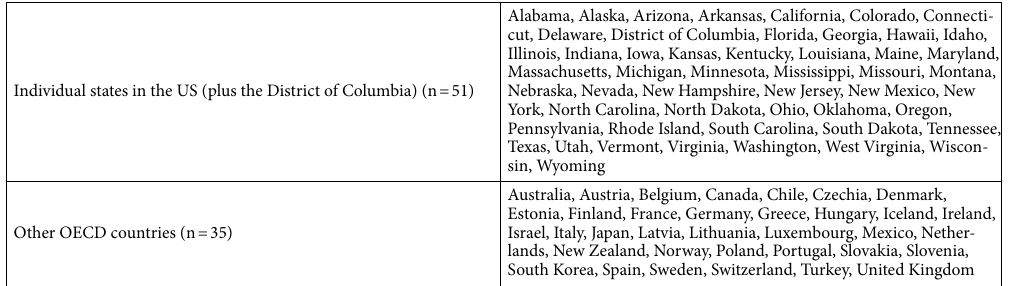
Table 1. List of the 86 geographic areas included in the study. OECD The Organization for Economic Co-operation and Development.